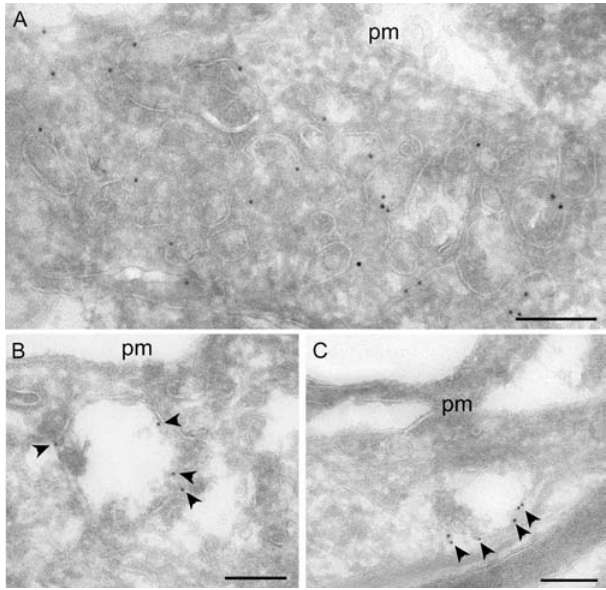
Figure 5. Immunolocalisation of Endogenous and Overexpressed Rabankyrin-5 in NIH3T3 Cells Untransfected NIH3T3 cells or cells transfected with Rabankyrin-5 were labelled with antibodies to Rabankyrin-5 followed by 10 nm protein A gold. (A) Transfected cell showing labelling of a group of vesicular structures underlying the plasma membrane (pm). (B and C) In control (untransfected) cells, low but specific labelling for Rabankyrin-5 (arrowheads) is associated with compartments close to the pm. Scale bars represent 200 nm. DOI: 10.1371/journal.pbio.0020261.g005